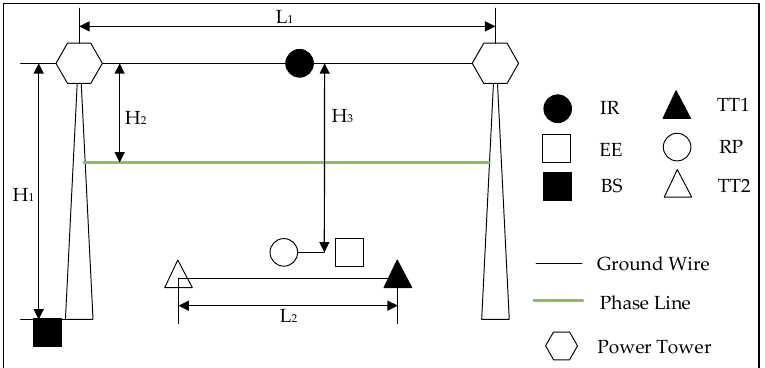
Figure 4. Deployment of the DBTRN in a span and distances between nodes.